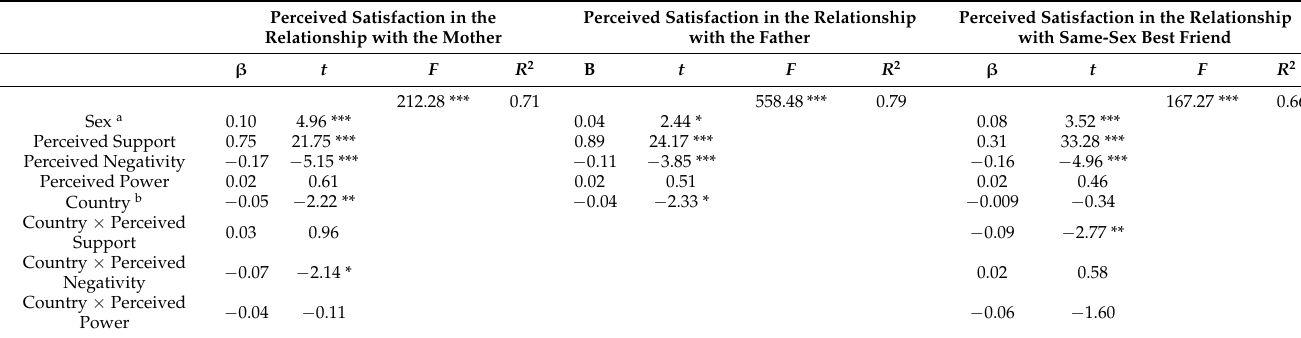
Table 2. Final regression models examining the predictive role of the perceptions of relationships with the mothers, fathers and same-sex best friends in satisfaction, depending on